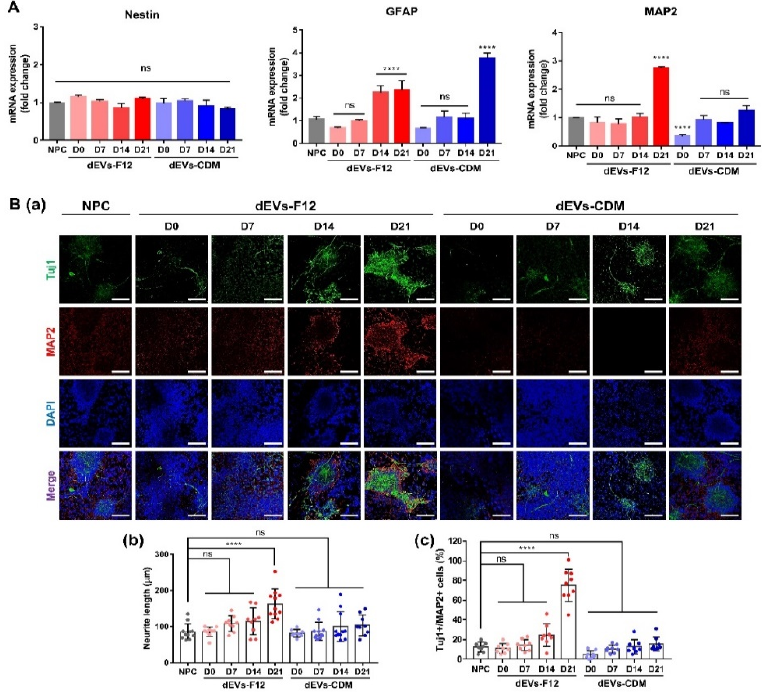
Figure 4. Enhanced neuronal differentiation effects of dEVs using NPCs under neural differentia- tion conditions after 7 days. ( A ) Neurogenesis-related gene expressions of dEV treated NPCs using RT-qPCR. ( B ) Representative images of immunofluorescence staining of differentiated NPCs labeled with neuronal markers ( a ) Tuj1 (green) and MAP2 (red). DAPI (blue) represents the nuclei of NPCs. Scale bars indicate 100 μ m. Quantifying neurite length ( b ) and Tuj-1/MAP2 copositive cell numbers ( c ). **** p < 0.0001 and ns = no significant. One-way ANOVA was followed by Tukey’s test. Error bars represent standard deviation (SD).